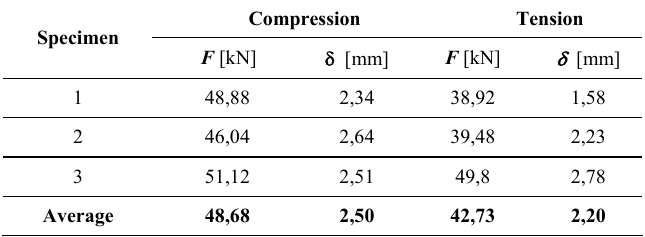
Table 3: Axial rigid connection tests results.